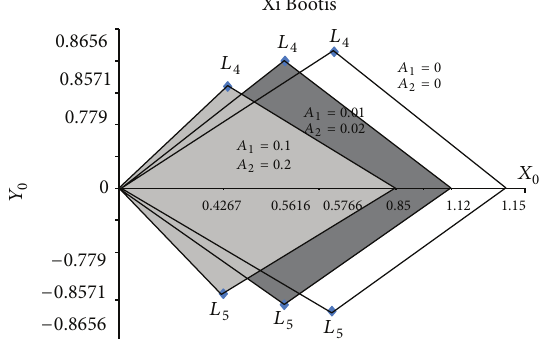
Figure5:LocationoftriangularpointsforXiBootiswith 𝐴 1 = 𝐴 2 = = 0.01 , 𝐴 = 0.02 , and 𝐴 0 , 𝐴 1 2